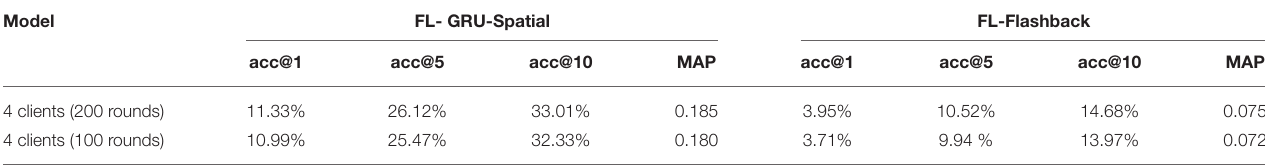
TABLE 4 | Accuracy for FL-GRU and FL-flashback with foursquare (10 epochs − 100 and 200 rounds).